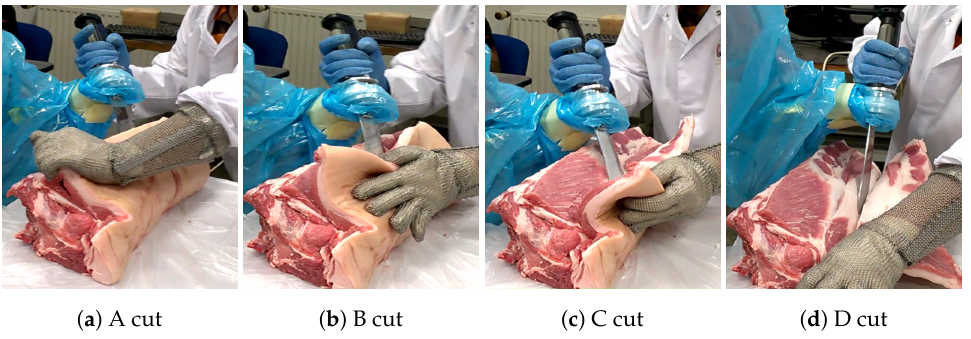
Figure 17. Experiment 1—cobot assisted pork cutting.